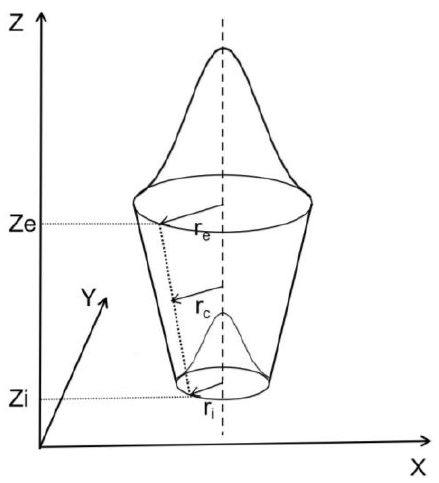
Figure 8. Conical heat source with the Gaussian distribution [31].